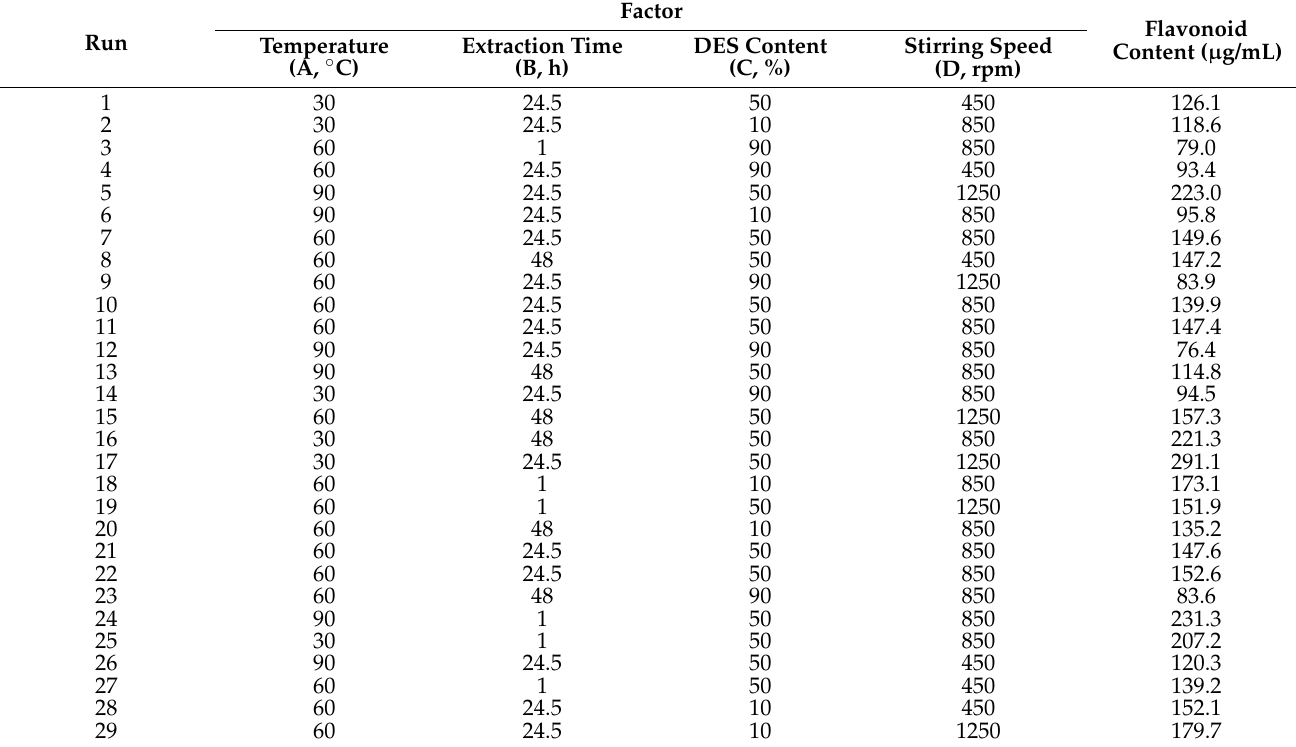
Table 2. Design and experimental response values based on BBD